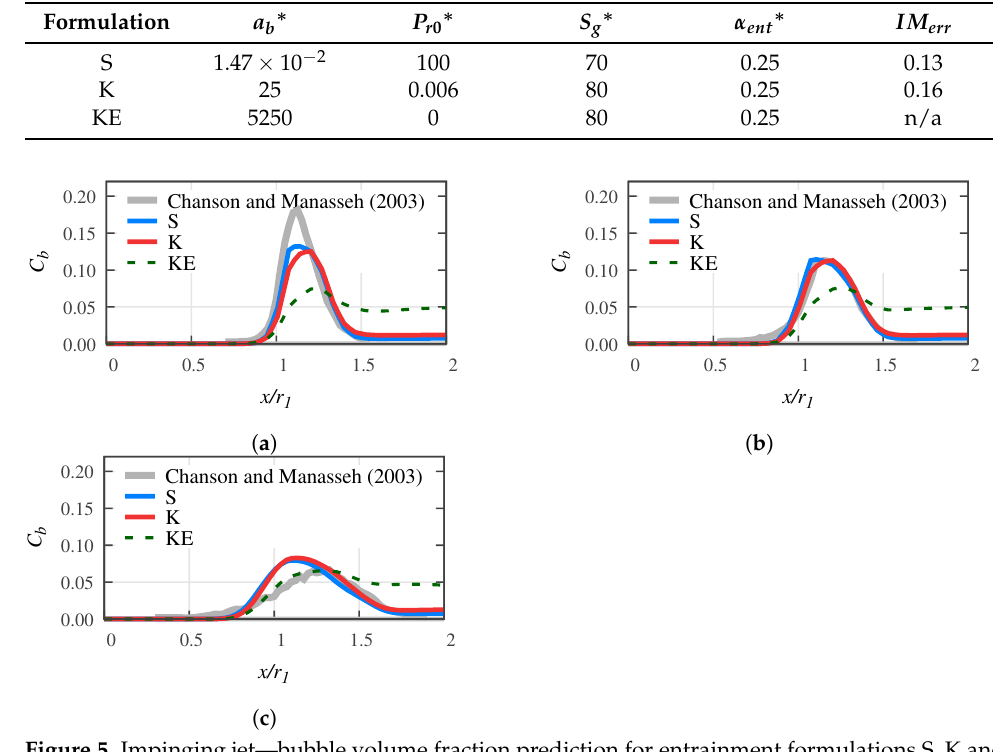
Figure 5. Impinging jet—bubble volume fraction prediction for entrainment formulations S, K